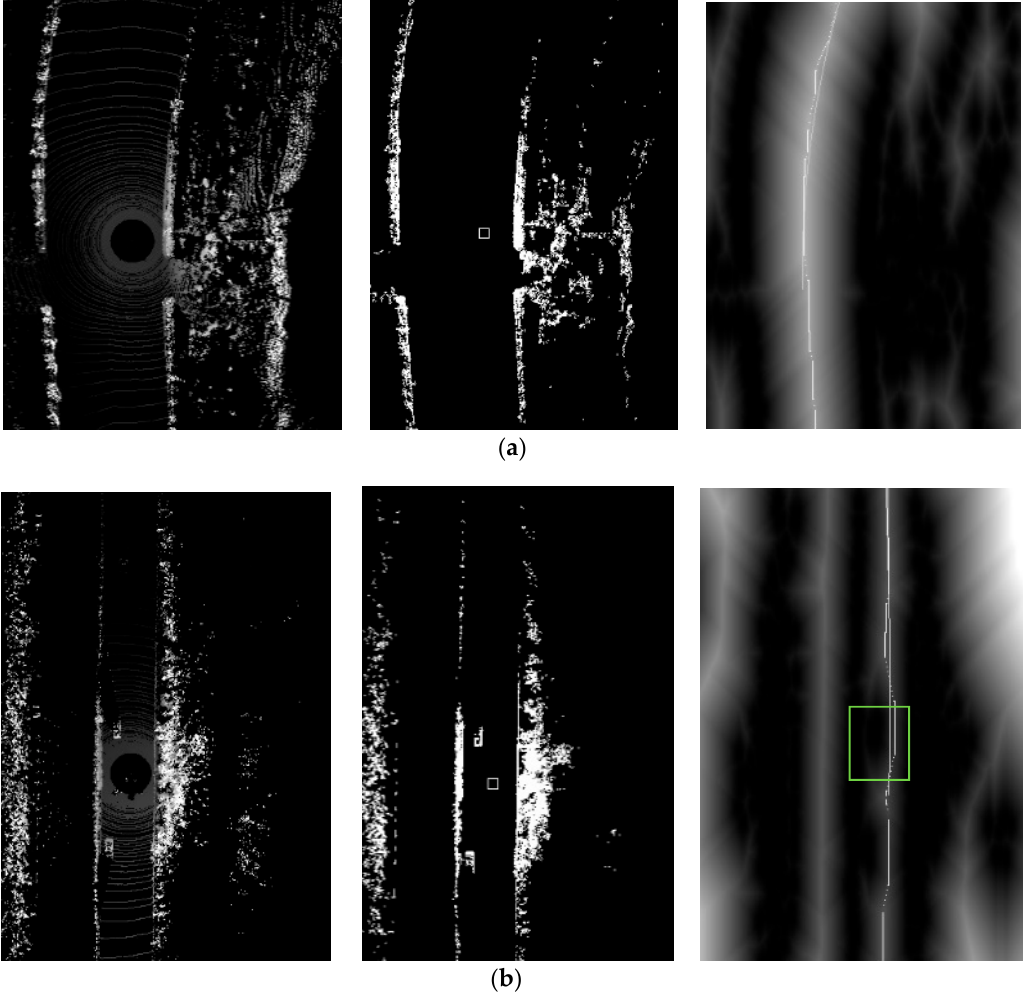
Figure 14. Results for road centerline extraction of a winding road and a straight road. ( a ) Centerline extraction for winding road; ( b ) Centerline extraction for winding road.